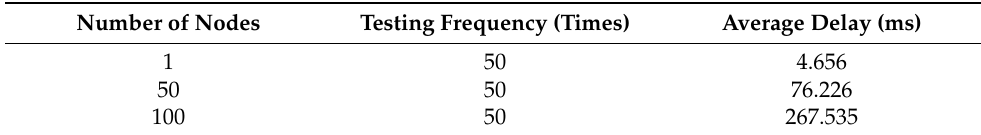
Table 8. Average signal delay under the LEACH protocol.